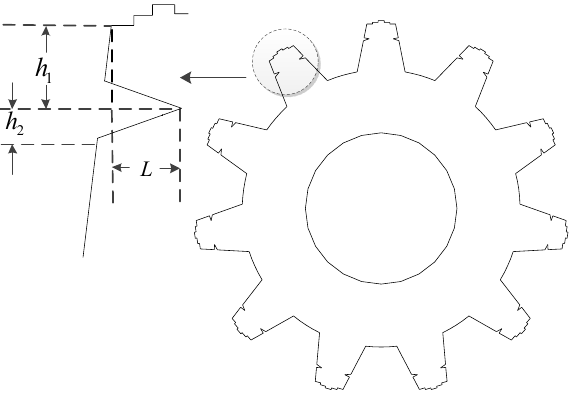
Figure 11. The model of rotor with the combination of stepped and notched